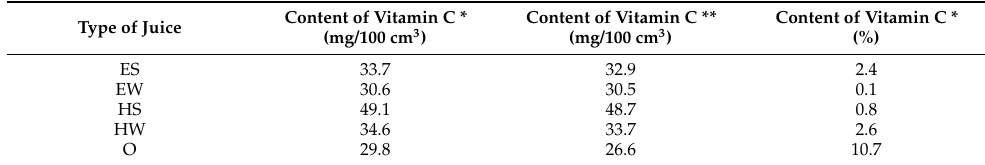
Table 3. Vitamin C content in orange juices before and after